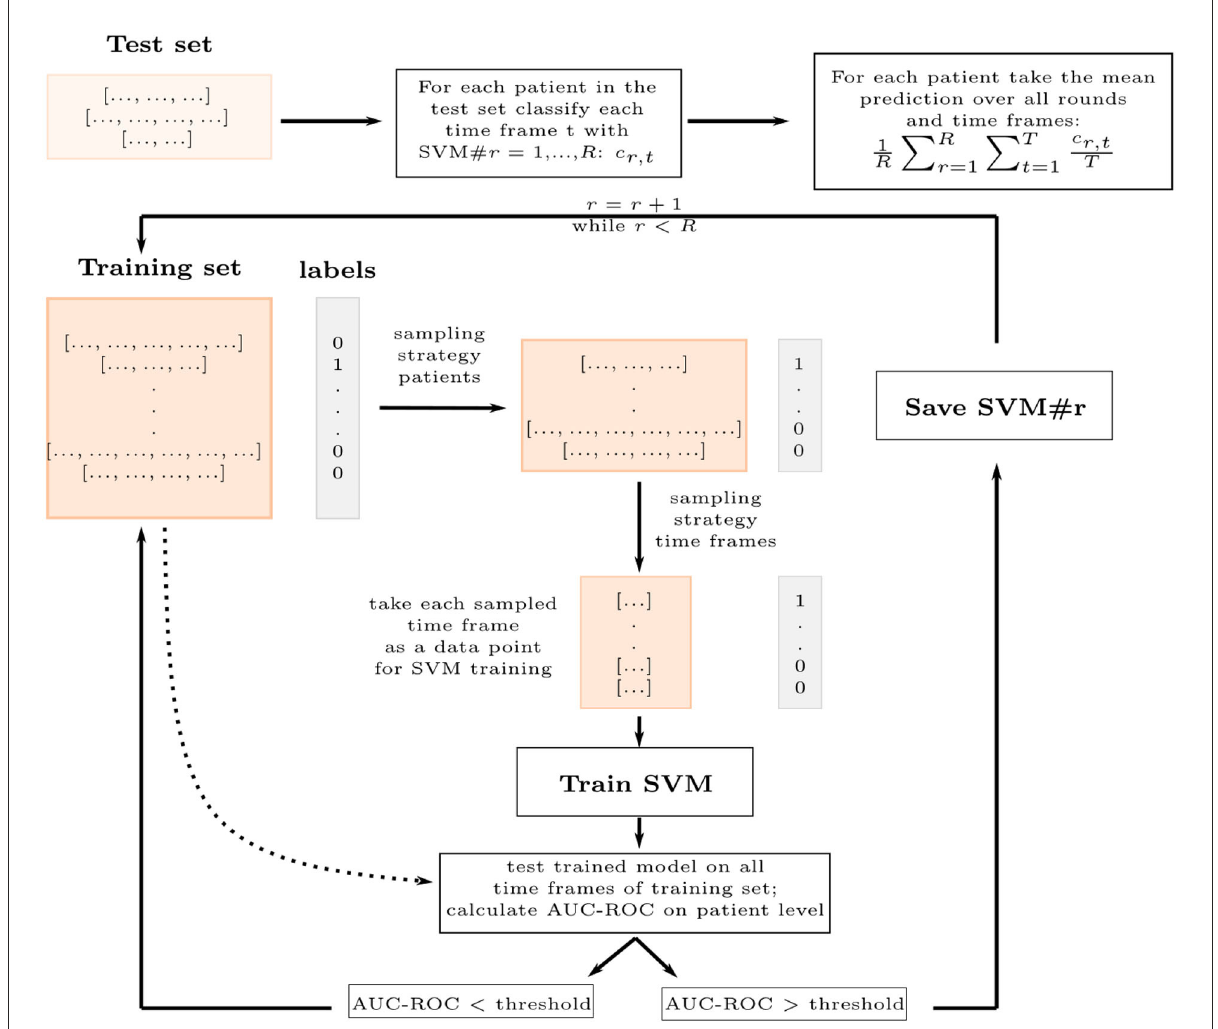
FIGURE2 Bagging classifier schematic for time-dependent data. The Bagging approach saves R SVM estimators trained on the training set to classify all time frames in the test set and calculate a probability to develop POD for each patient in the test set. The SVMs are trained on sampled time frames as data points, the result of two stages of sampling on the training set: the strategy for patient sampling and the strategy for time frame sampling. The covariance features are projected to a Euclidean space before classification (Figure 3). If the AUC-ROC on the whole training set is good enough, the SVM is